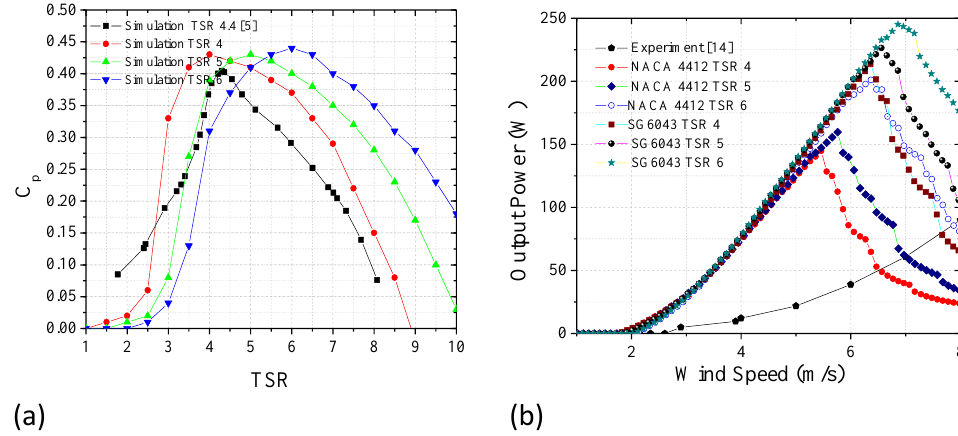
Figure 22. Comparison of ( a ) power coefficients; ( b ) output powers [14].